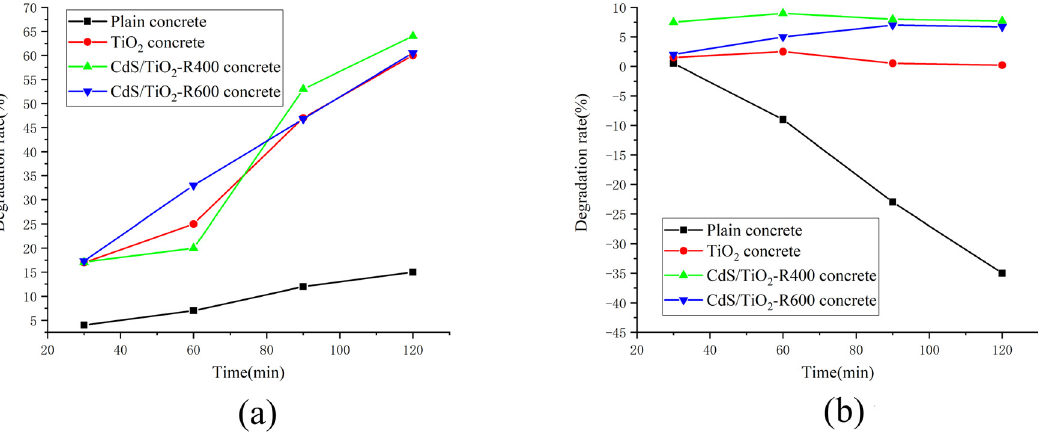
Figure 4: Comparison of photocatalytic performance between plain concrete and nanocomposite concrete. ( a ) Ultraviolet light ( b ) visible light.